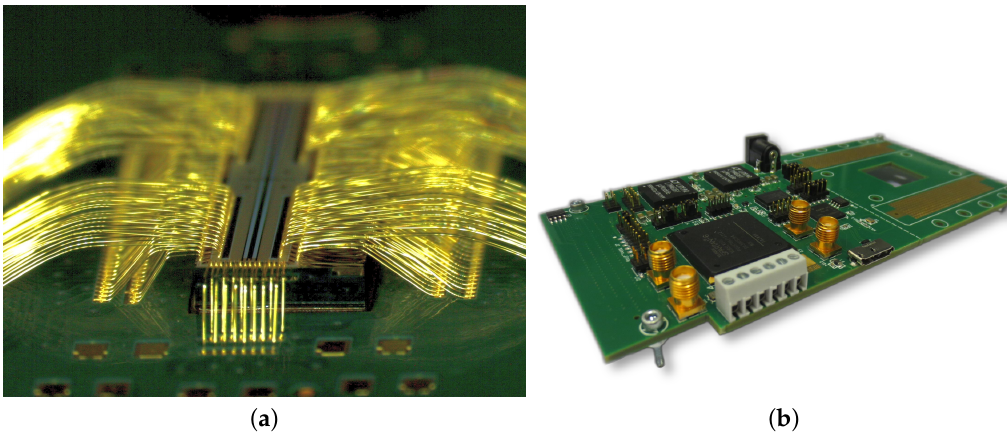
Figure 2. ( a ) Close-up of the LinoSPAD sensor glued to its PCB. Due to the high number of bond wires, the PCB layout was made following specifications from the bonding company. All pixels have at least a 90 ◦ aperture for incoming light (Image courtesy of Microdul AG, Zürich); ( b ) FPGA (field-programmable gate array) motherboard with two large 10 × 40 contact arrays around a hole foreseen for backside cooling. Two spring connector arrays connect the daughter PCB, which contains only few decoupling capacitors in addition to the